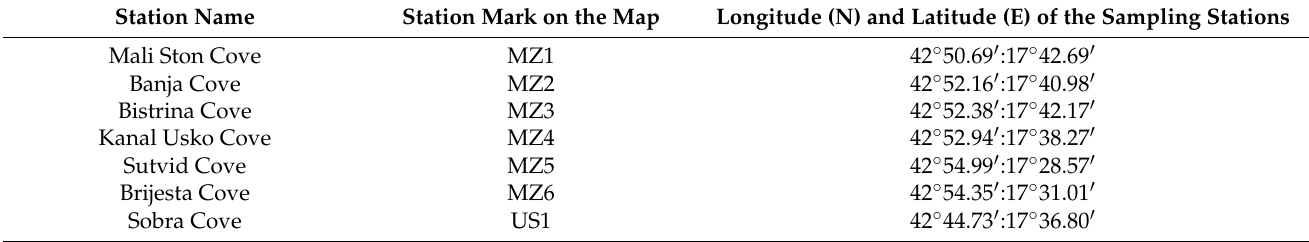
Figure 1. The Bay of Mali Ston map with locations of sampling stations. Table 1. Longitudes and latitudes of the sampling